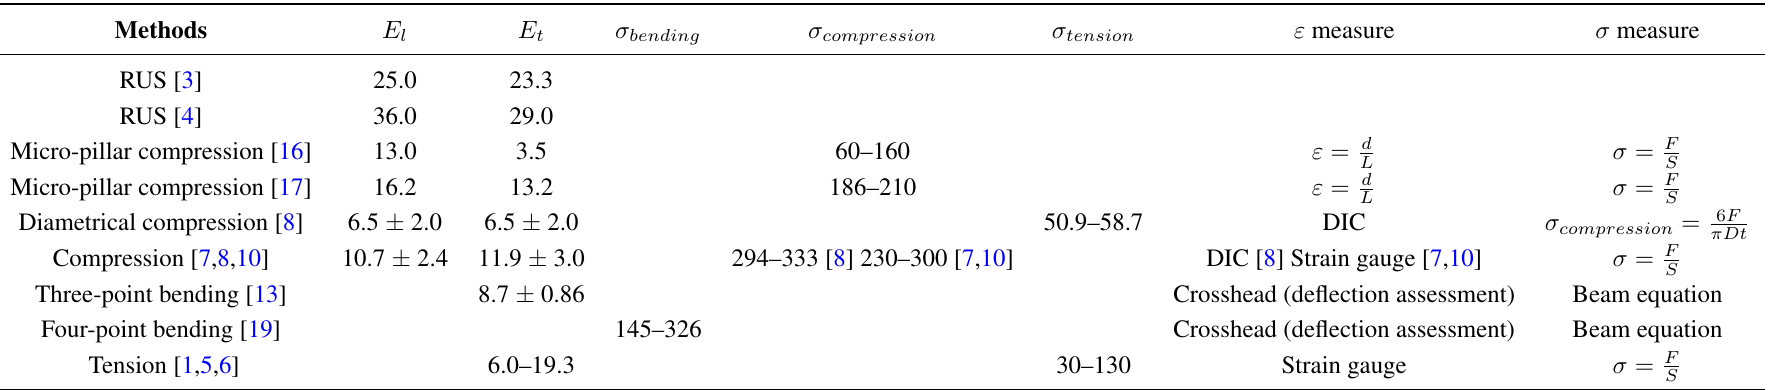
Table 1. Literature review of the mechanical properties of human dentin (elastic modulus units: GPa, stress unit: